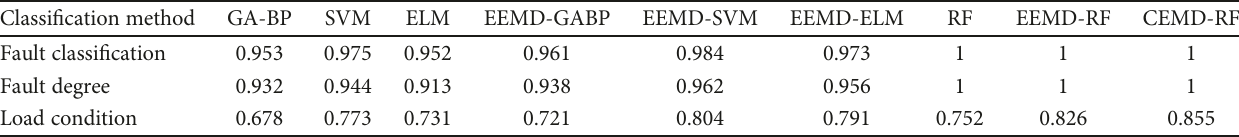
Table 3: The diagnosis accuracy of every